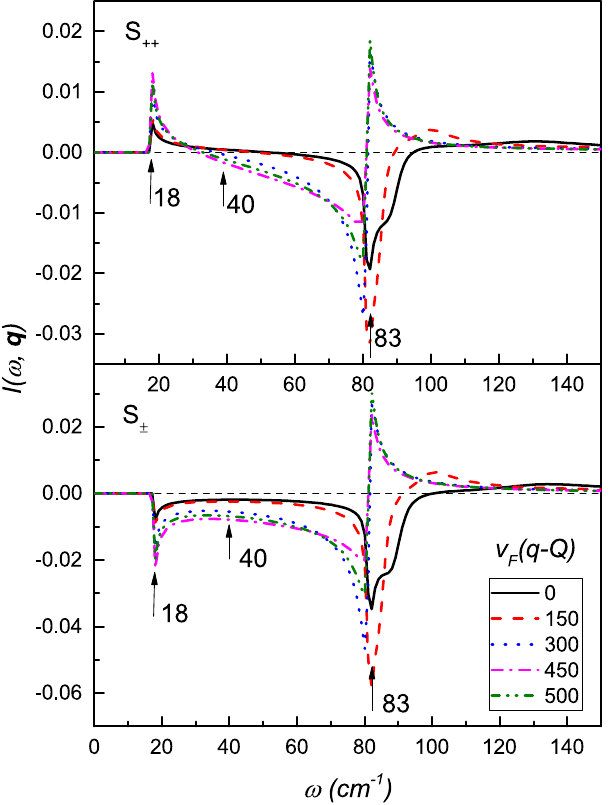
Figure 5. The QPI response function I( ω , q ) of the scattering between the electron and the hole bands, for the s ++ and s ± symmetry of the superconducting order parameter at various momentum values with parameters as, ε = 200, δμ = 300, and φ = 0 with β = 1, and at temperature T = 1 cm − 1